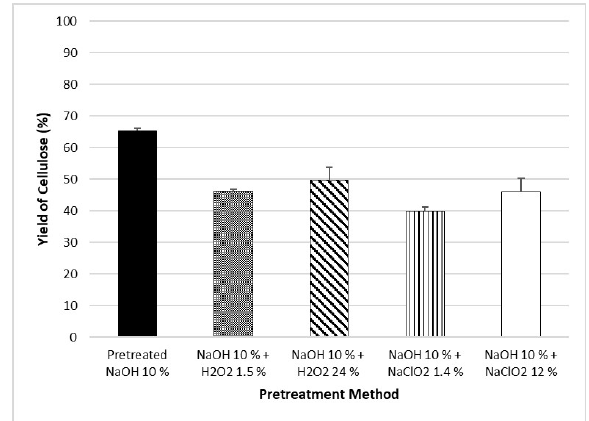
Fig. 3. Cellulose yield from OPEFB after pretreatment